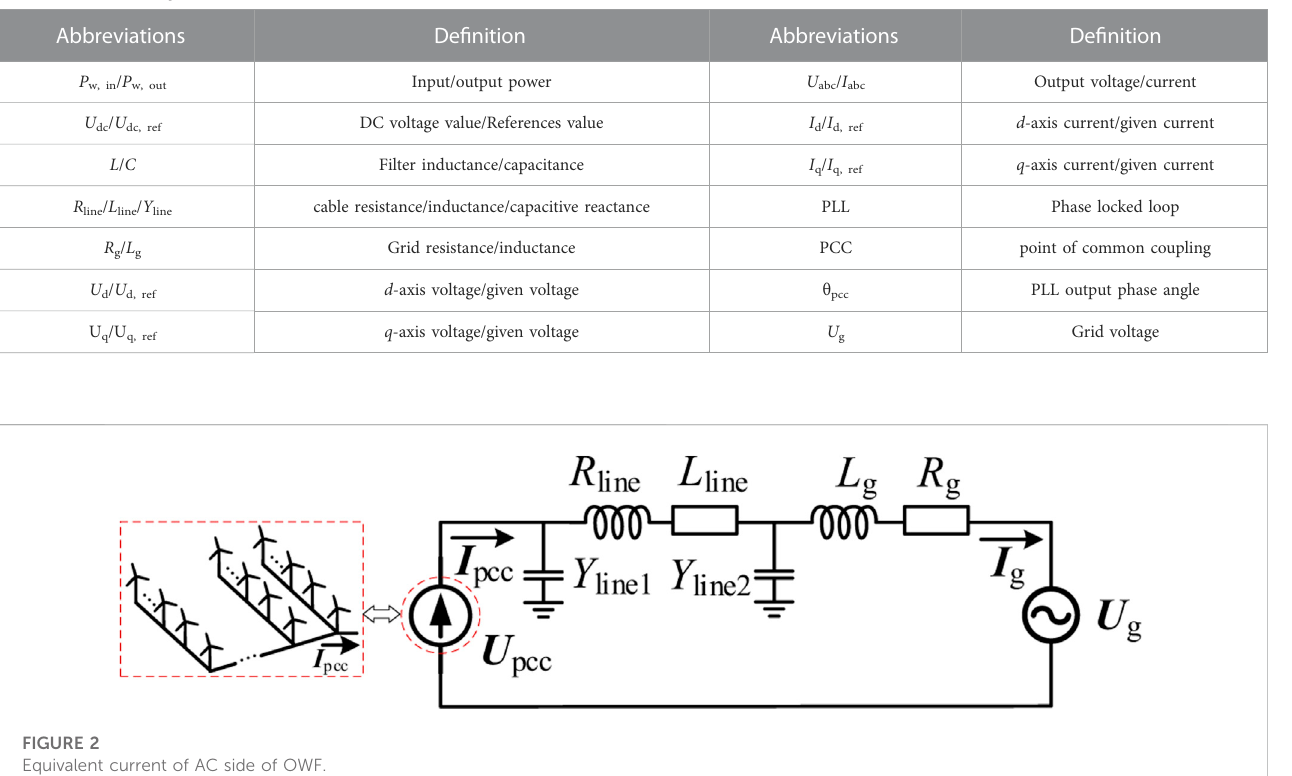
TABLE 1 De fi nition of parameters abbreviations.